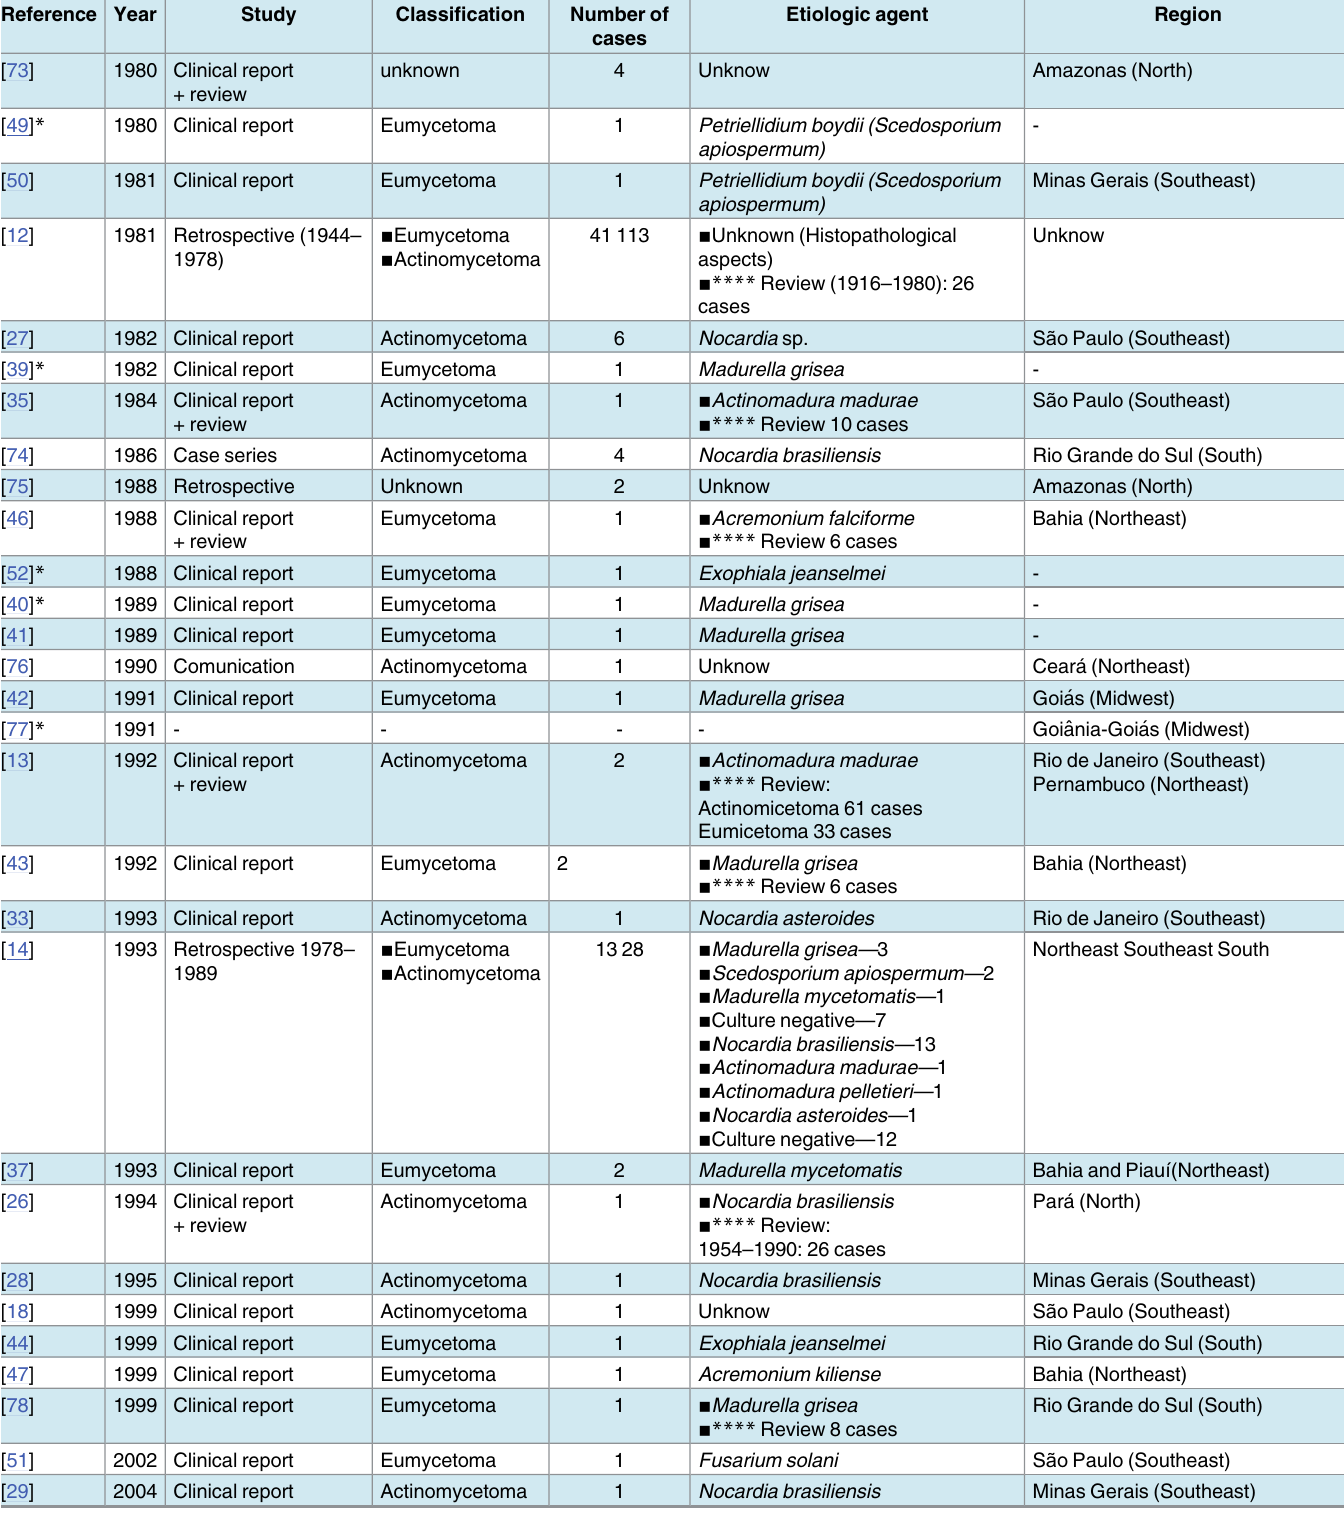
Table 4. Mycetoma cases in Brazil published during